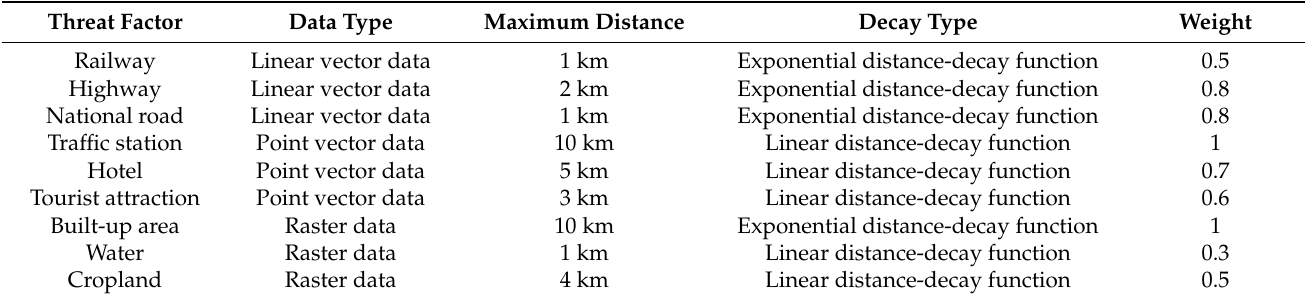
Table 2. Threat factors of habitat quality and their